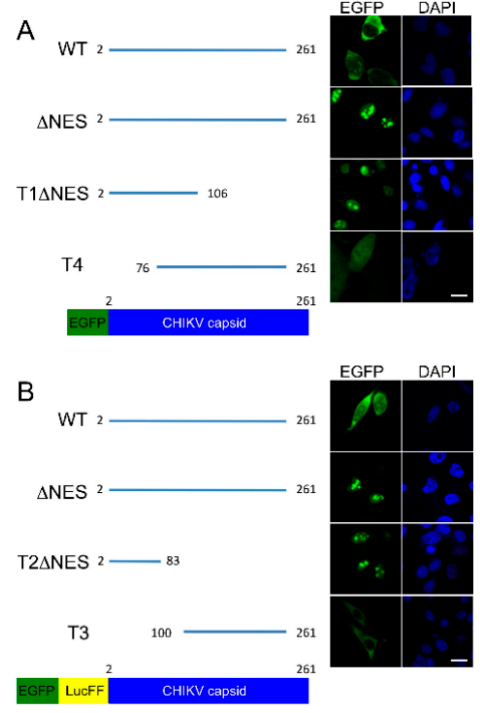
Figure 3. The N-terminus is required for active nuclear targeting of CHIKV capsid protein. ( A ) BHK- 21 cells were transfected with either CHIKV WT EGFP-capsid, EGFP- ∆ NES, EGFP-T1 ∆ NES, EGFP-T4 or, to ensure nuclear translocation was not due to passive diffusion; ( B ) CHIKV WT EGFP-LucFF- capsid, EGFP-LucFF- ∆ NES, EGFP-LucFF-T2 ∆ NES, EGFP-LucFF-T3, which contain an insertion of the luciferase firefly gene (LusFF) between EGFP and the capsid gene to increase the overall molecular weight of the recombinant protein. After 24 h, cells were fixed and EGFP and fluorescence analyzed by direct visualization. Images are representative of three independent experiments and at least six fields of view. The white bars represent 15 µm. least six fields of view. The white bars represent 15 µ